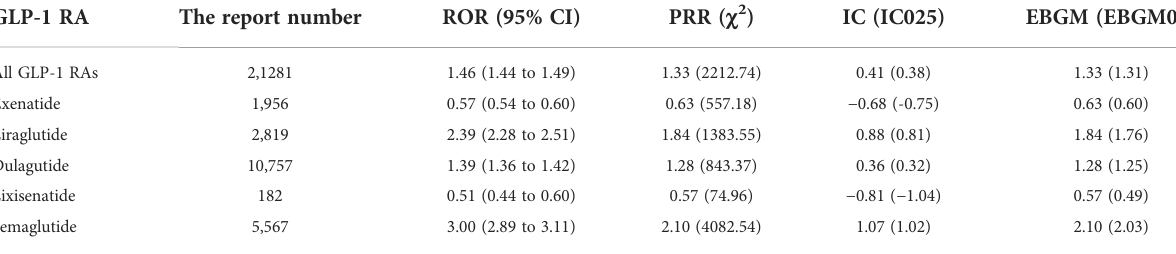
TABLE 2 Signal detection for GLP-1 RAs-associated gastrointestinal adverse events. GLP-1